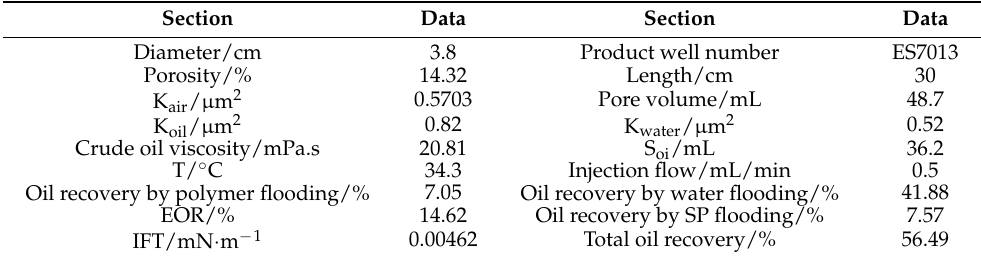
Table 3. Experiment of SP flooding after polymer flooding.